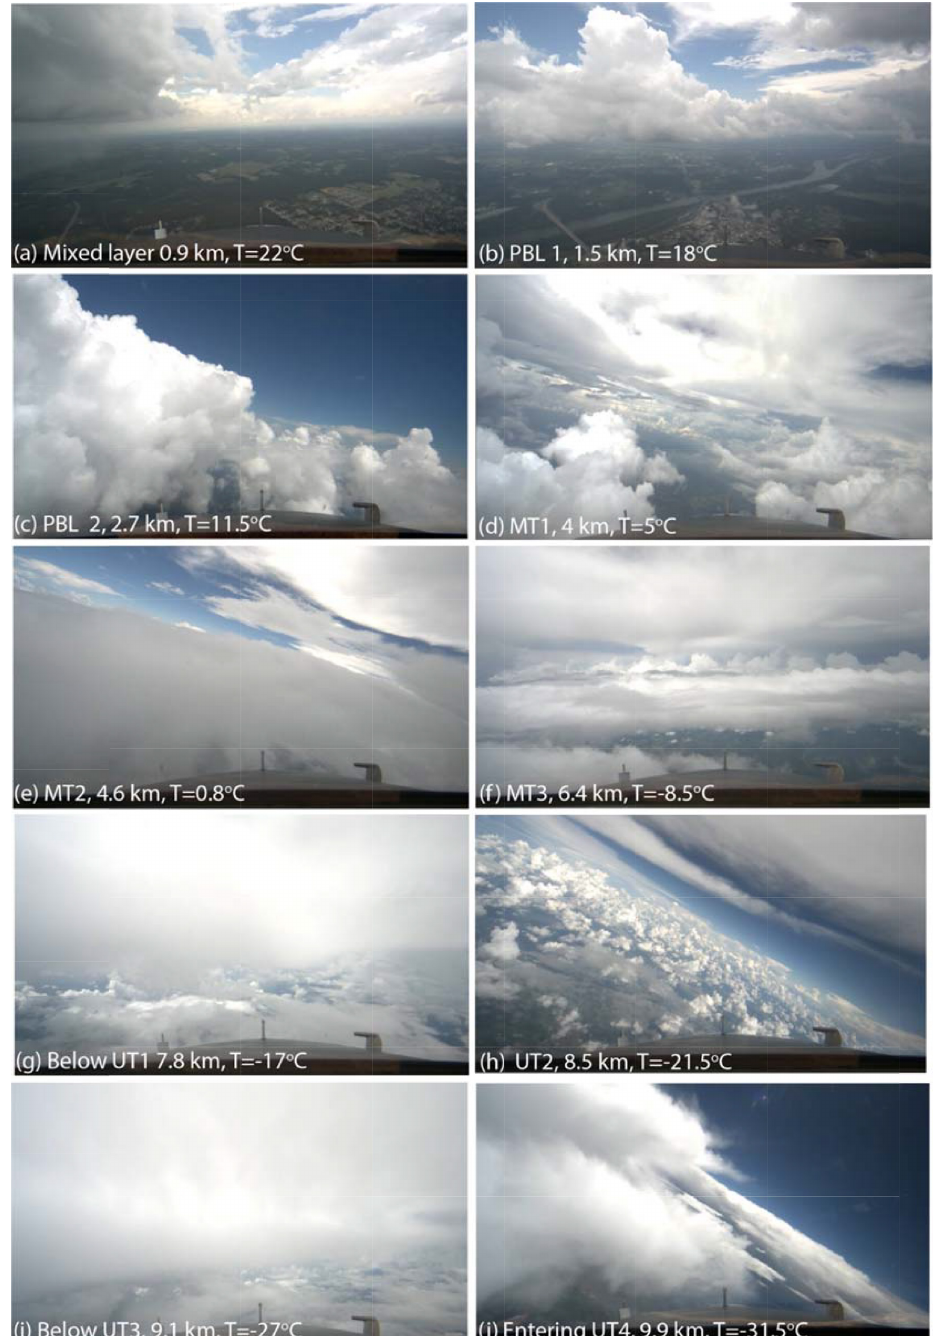
Figure A4. Forward camera images from the DC-8 forward video taken from the leeward spiral along the sampled thunderstorm on 12 Au- gust 2014 over northwestern